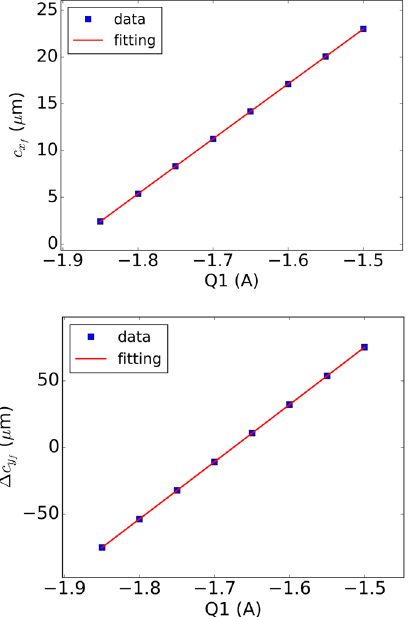
FIG. 2. Typical fits for a single bunch in both planes without any jitter.